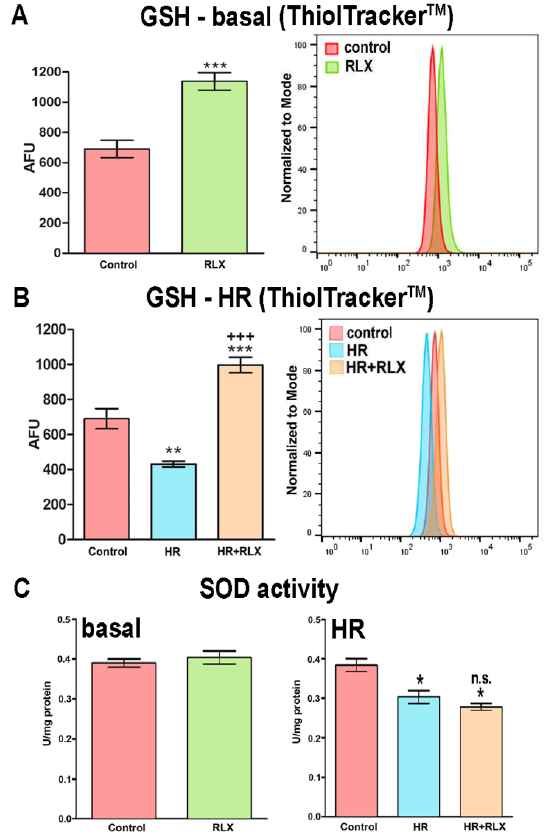
Figure 5. Quantitative evaluation and representative FACS diagrams of cellular antioxidant systems by fluorescent probes. Levels of reduced glutathione (GSH) in normal cells ( A ) and in cells subjected to HR ( B ), evaluated by ThiolTracker ™ Violet. RLX markedly increases intracellular GSH in both normal and HR-exposed cells. Activity of superoxide dismutase (SOD) in normal cells and in cells subjected to HR ( C ). In either condition, RLX did not induce changes in SOD activity. (AFU: arbitrary fluorescent units). Significance of di ff erences ( n = 3): *** p < 0.001, ** p < 0.01, * p < 0.05 vs. controls; +++ p < 0.001, n.s. not significant vs.